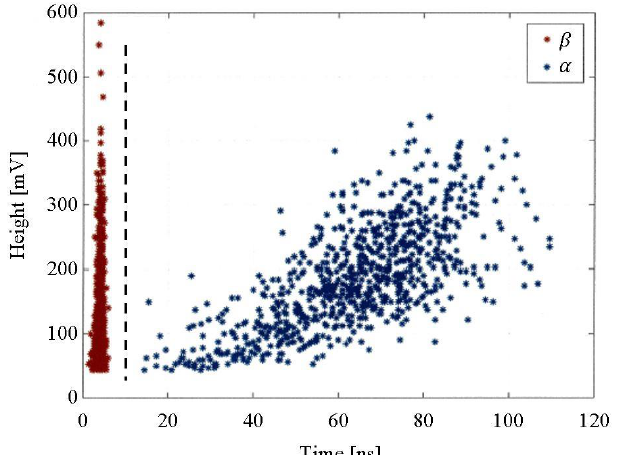
Fig. 2. The distribution of the alpha and beta pulses over the amplitude-decay time